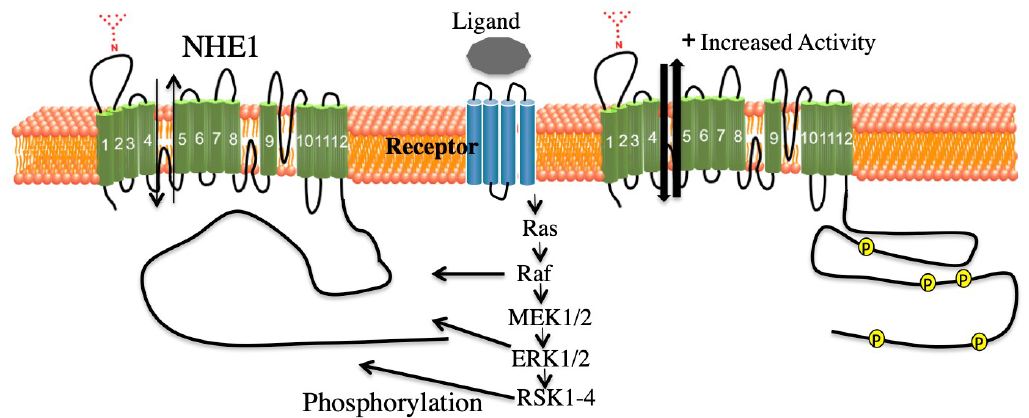
Figure 5. Simplified schematic of the hypothetical ERK signaling cascade that activates the Na + / H +